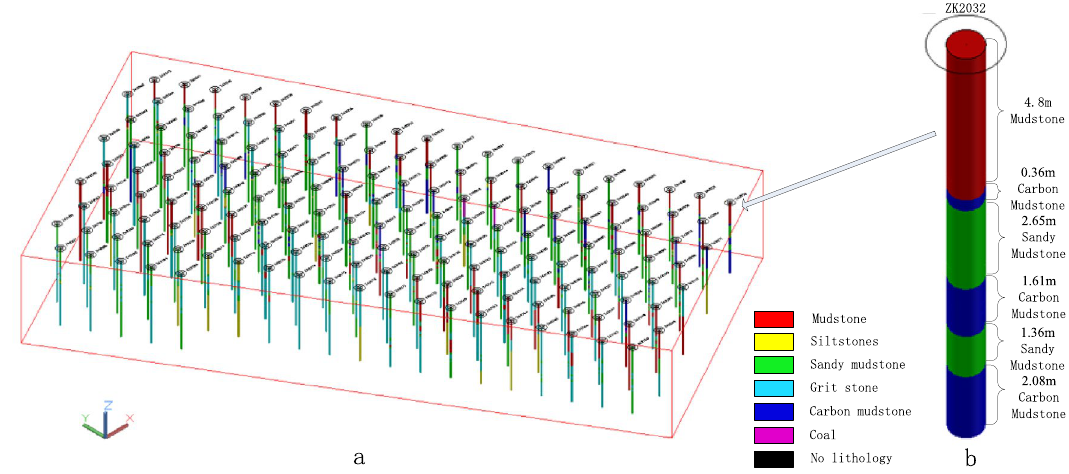
Figure 6. 3D histogram of blasting holes: ( a ) three-dimensional histogram of all blasting holes; ( b ) ZK2032 borehole Draw blast hole position. Select the range on the graph, and draw the blast holes of the selected range into the graph. The point in the graph is the location of the blast hole, and the blast holes are marked. The result is shown in Fig. 5. The blast holes are shown in the figure refer to No. 918 bench blasting blast holes in the Shengli open- pit coal mine of Xilinhot.. Draw the blast hole histogram. The three-dimensional histogram is displayed in a three-dimensional form, and the structural distribution and specific thickness of the ore and rock strata inside the blast hole can be seen clearly, as shown in Fig. 6. The three-dimensional histogram of all blasting holes in the No. 918 bench of an open-pit coal mine in Xilinhot is shown in Fig. 6a; the three-dimensional histogram of a single blast hole is shown in Fig. 6b. The rocks with different lithologies are filled with three-dimensional solid of different colors. The rock thickness and lithology name are marked beside the three-dimensional rock column. The figure is the three-dimensional histogram of the ZK2032 blast hole, with a total of six layers of rocks. From the orifice to the bottom of the hole, the rock name and thickness are mudstone 4.8 m, carbon mudstone 0.36 m, sandy mudstone 2.65 m, carbon mudstone 1.61 m, sandy mudstone 1.36 m, and carbon mudstone 2.08 m. Establishment of 3D solid model of rock mass in blasting area. Interpolate 3D solid model. With- in the blasting range, it is divided into many cube entities at a distance of 2 m (2 m in length, width, and height),